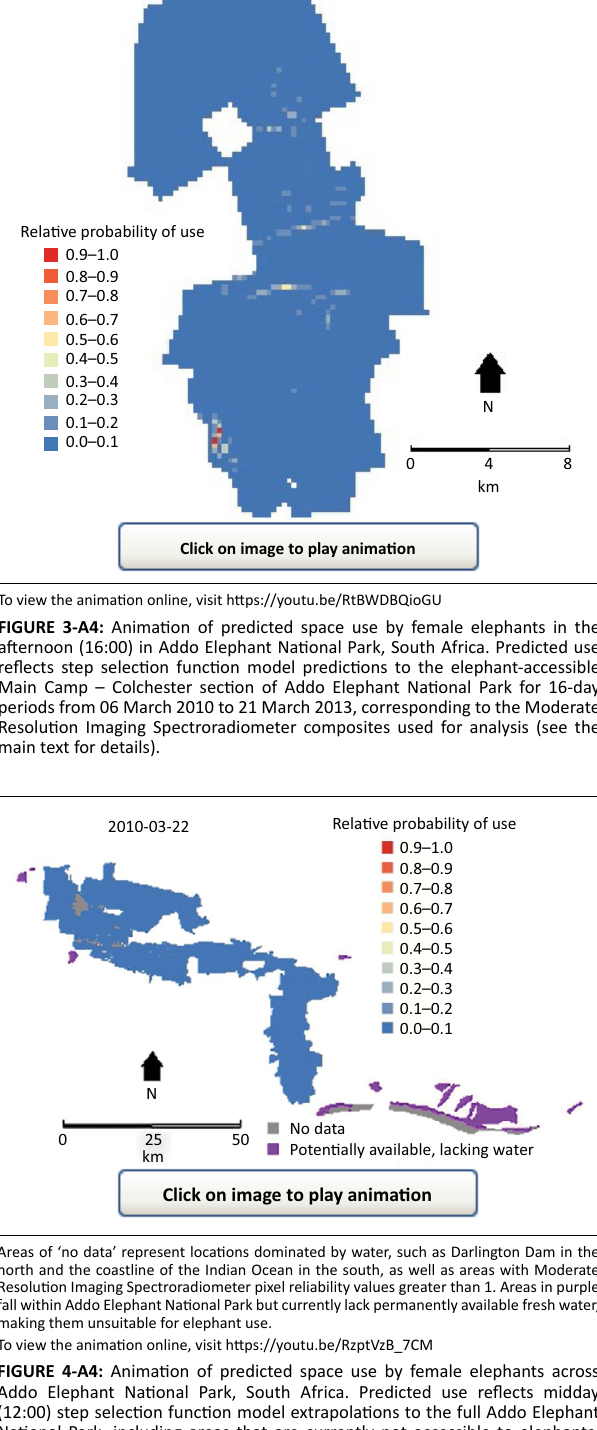
FIGURE 2-A4: Animation of predicted space use by female elephants at midday (12:00) in Addo Elephant National Park, South Africa. Predicted use reflects step selection function model predictions to the elephant-accessible Main Camp – Colchester section of Addo Elephant National Park for 16-day periods from 06 March 2010 to 21 March 2013, corresponding to the Moderate Resolution Imaging Spectroradiometer composites used for analysis (see the main text for details).